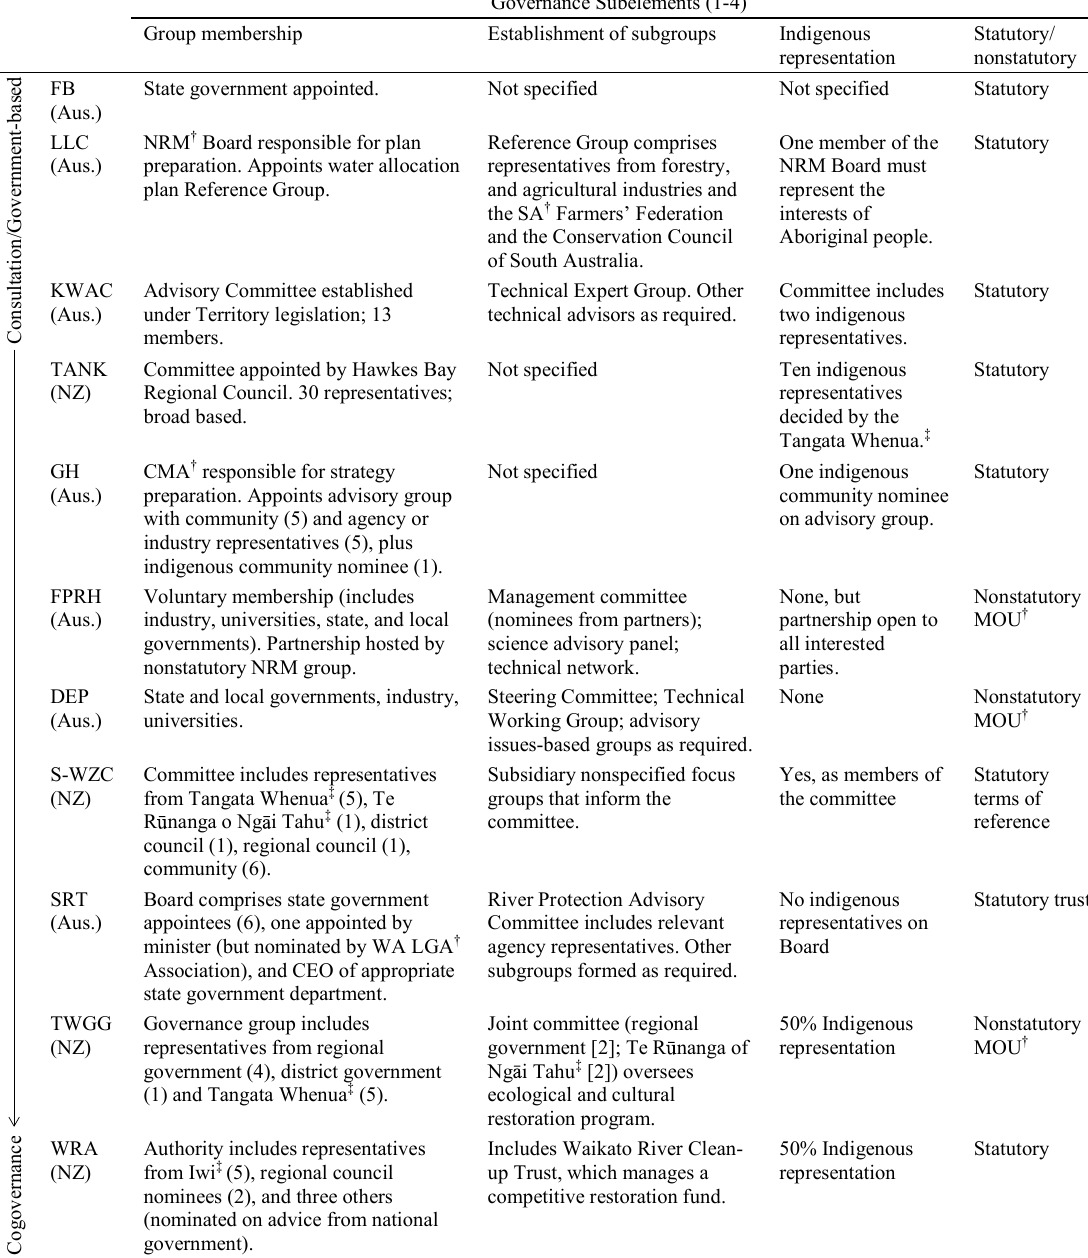
Table 4 . Categorization of collaborative groups along the consultation/government-based to cogovernance continuum: Governance subelements